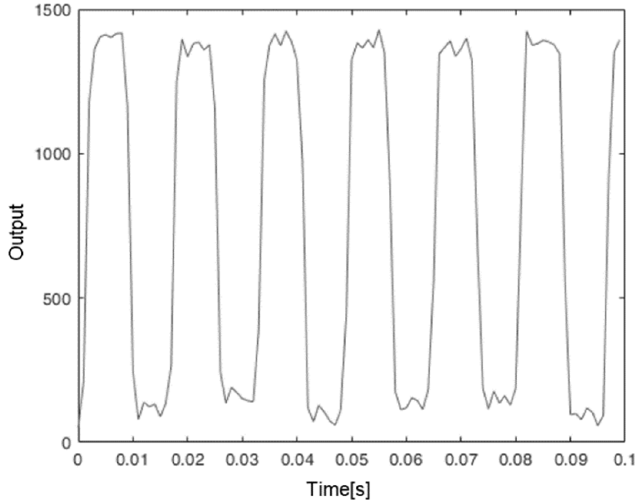
Figure 11. The output of the proposed sensor vs. time for the chopper disk placed 6.5 m from the sensor.